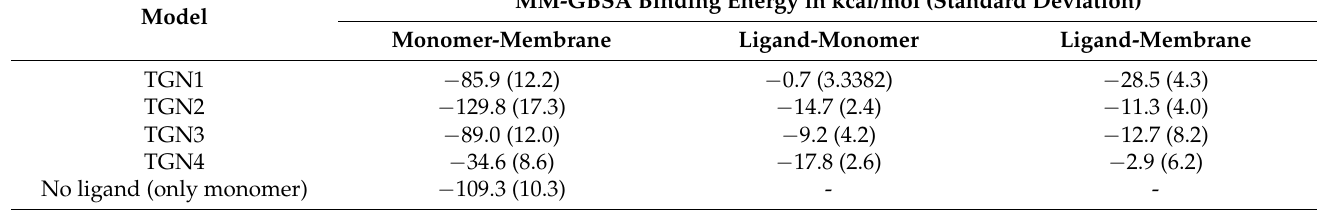
Table 2. Interaction of the A β 1–42 monomer and ligands with the POPC molecules. Molecule-bilayer binding energies (MM-GBSA) of all models were calculated over the full trajectories and are listed here.